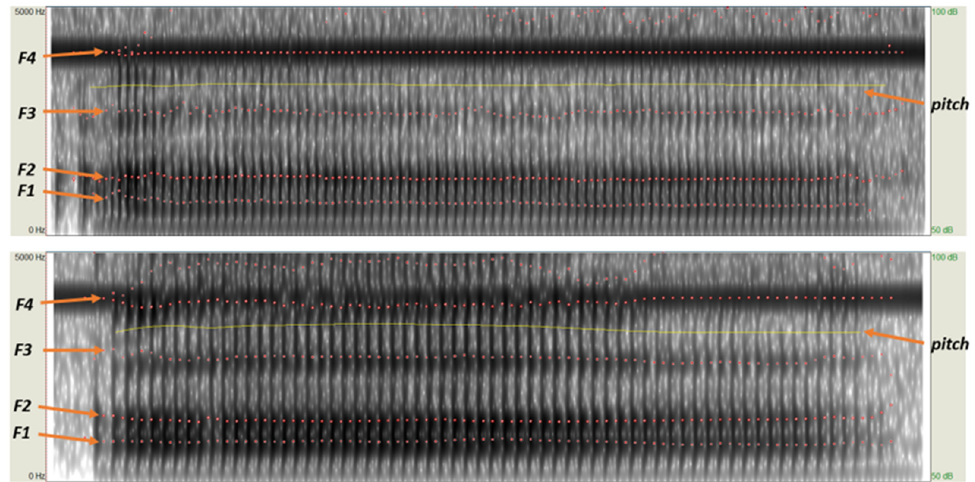
Figure 9. An example of a comparison in the time-domain of the formant frequency, pitch, and vocal tract is made when User 1 and User 2 pronounce the vowel “a”. Based on the findings of this study, it is evident that signals from the exact speaker yield minor differences in the tongue and vocal tract.